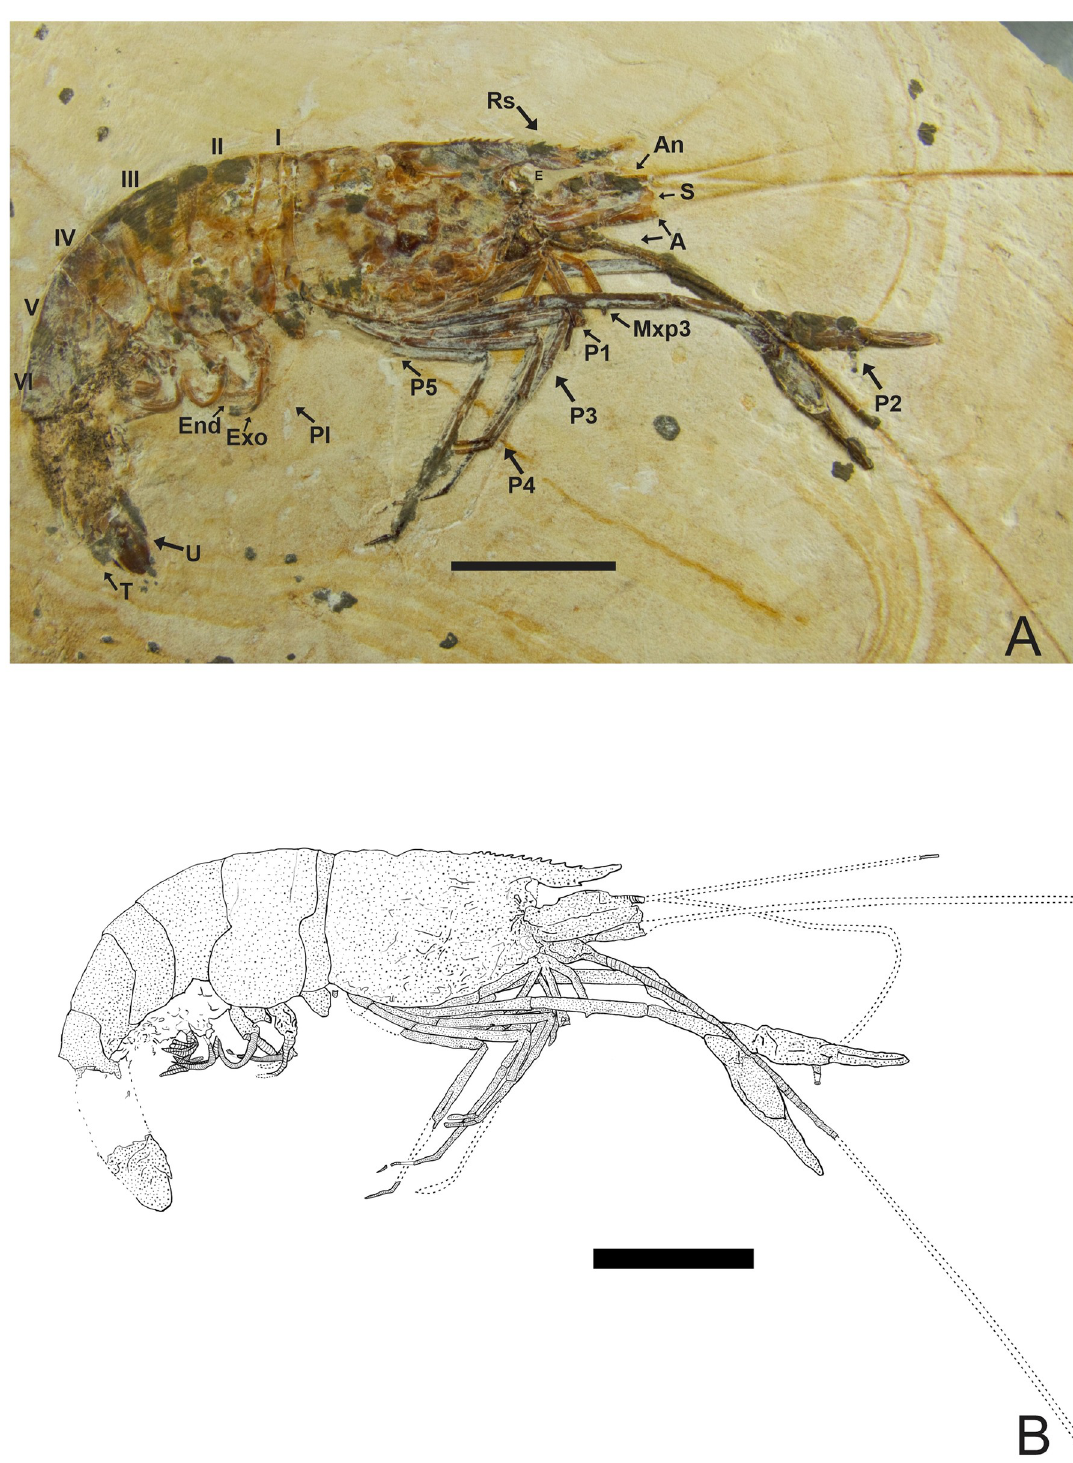
Fig 5. Lateral view of the specimen 1673/LPU. (A) Detail of the second pereiopod is represented by chelipeds. (B) Reconstitution, dotted lines represent appendages not preserved but with impressions on the matrix. Rs: Rostrum; An: Antennule; A: Antenna; S: Scaphocerite; Mxp3: Third maxilliped; P1-P5: Pereiopods; Pl: Pleopods; End: Endopod; Exo: Exopod; I-VI: Pleon; T: Telson; U: Uropods. Scale bars: 10 mm. Photo and drawing by Olga A. Barros.